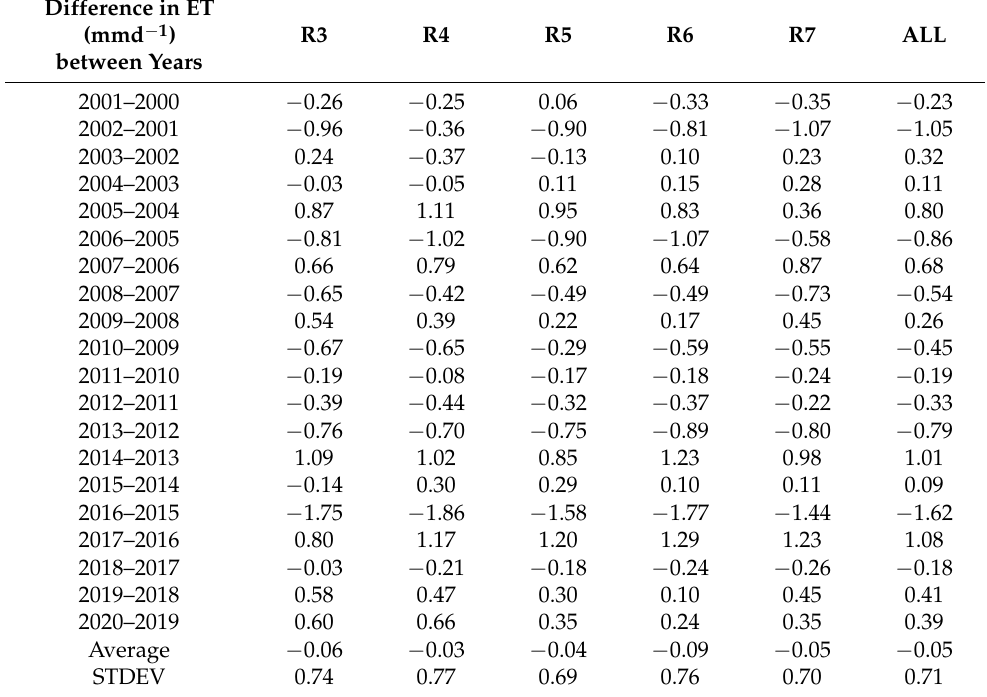
Table A6. Differences in the average daily water use using dates for the peak growing season (May 1 to October 30) for each of the 21 years in the study by subtracting the following year from the initial the data are shown for each reach and the weighted average in All reaches, with the average and standard deviation over the study period provided in the last two lines of the